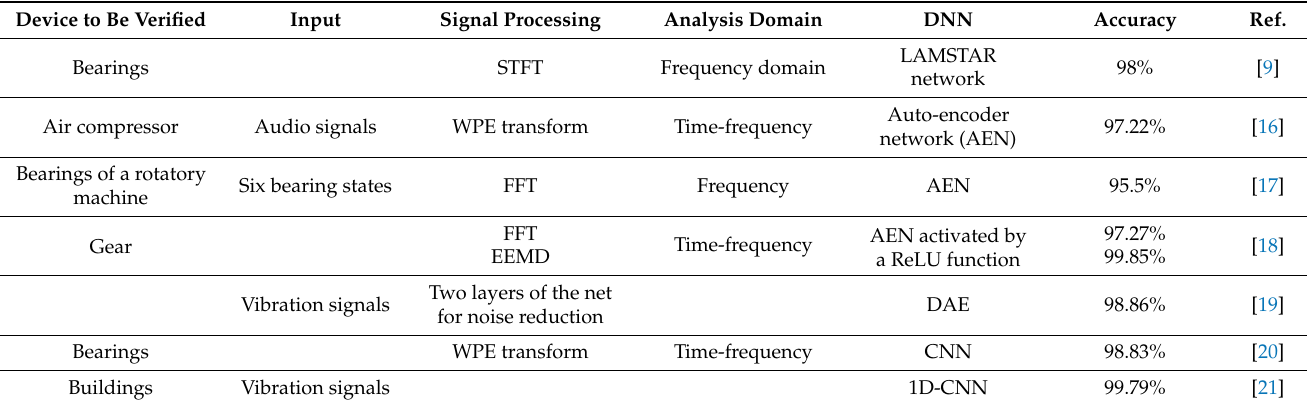
Table 1. Application of DNN model in fault